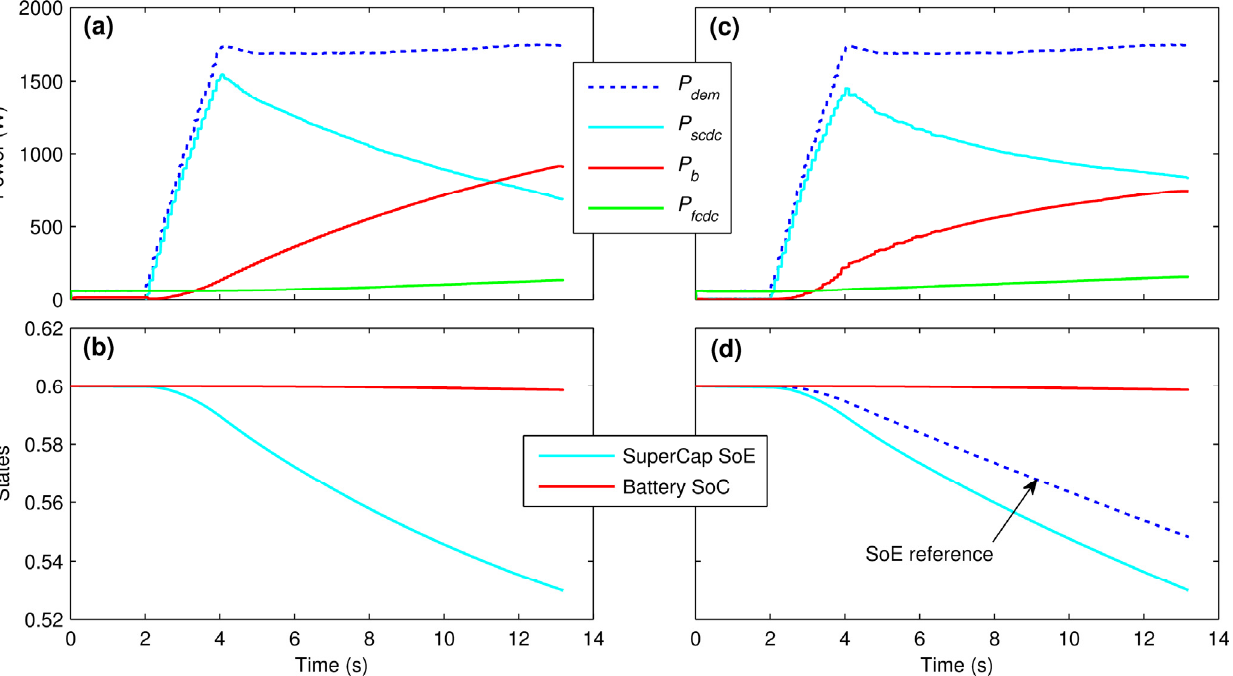
Figure 12. Experimental evaluation of the two strategies, S1 and S2, during the acceleration phase. ( a ) S1 power distribution; ( b ) S1 states trajectories; ( c ) S2 power distribution; ( d ) S2 states